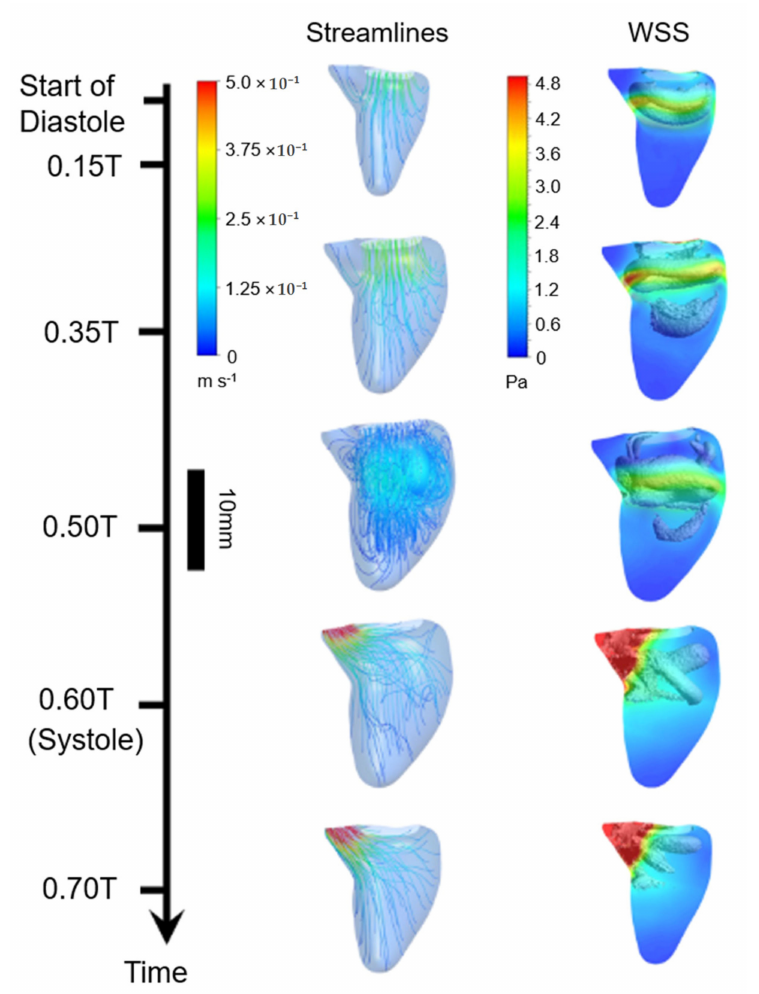
Figure 7. Flow streamlines and WSS patterns in a human fetal left ventricle considering various instants over the cardiac cycle. T is the period of cardiac cycle. In WSS plots, isosurfaces of vortex rings with recirculatory flow are shown. Relatively higher WSS levels are observed around the wall proximity of vortex rings (Reproduced from Lai et al. (2016)